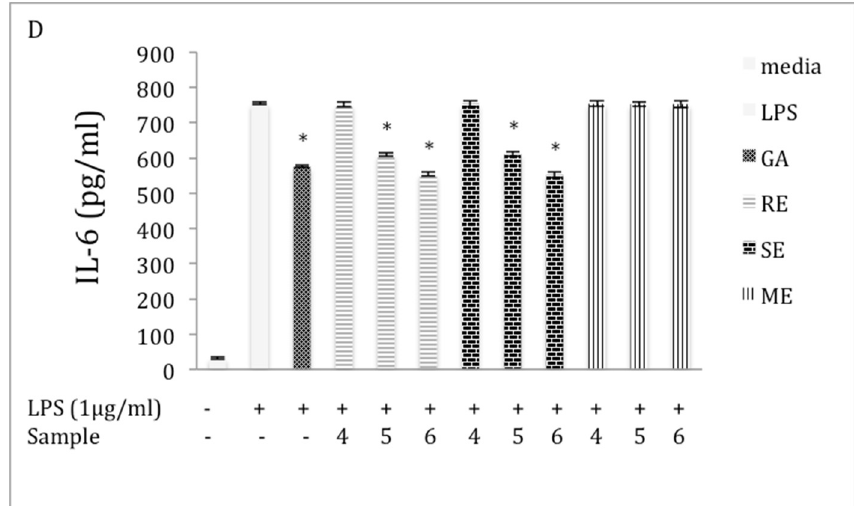
Figure 4. Effect of extracts and phenolics on IL-6 expression in macrophage RAW 264.7 cells ( A ) extracts obtained by ASE; ( B ) pure phenolic acid standards; ( C ) crude polysaccharide extracts; and ( D ) different extraction methods. Cells were cultured in the absence or presence of LPS (1 μ g /mL) with various concentrations of different samples for 24 h (0 = media; GA = 2 μ M; 1= 5 μ M; 2 = 10 μ M; 3= 20 μ M; 4 = 50 μ g/mL; 5 = 100 μ g/mL; and 6= 150 μ g/mL; 7= 25 μ M; 8 = 50 μ M; and 9 = 100